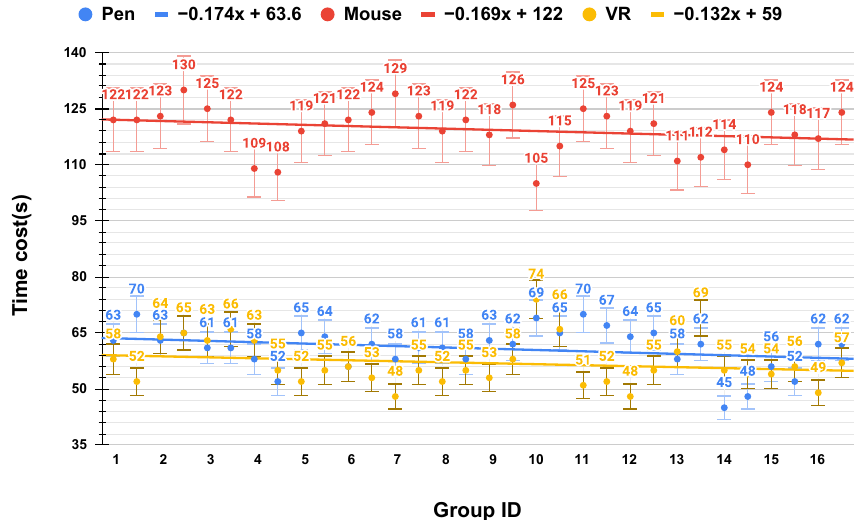
Figure 4. The time cost of experiment tasks when using a traditional whiteboard (pen), electronic whiteboard (mouse), and the proposed VR